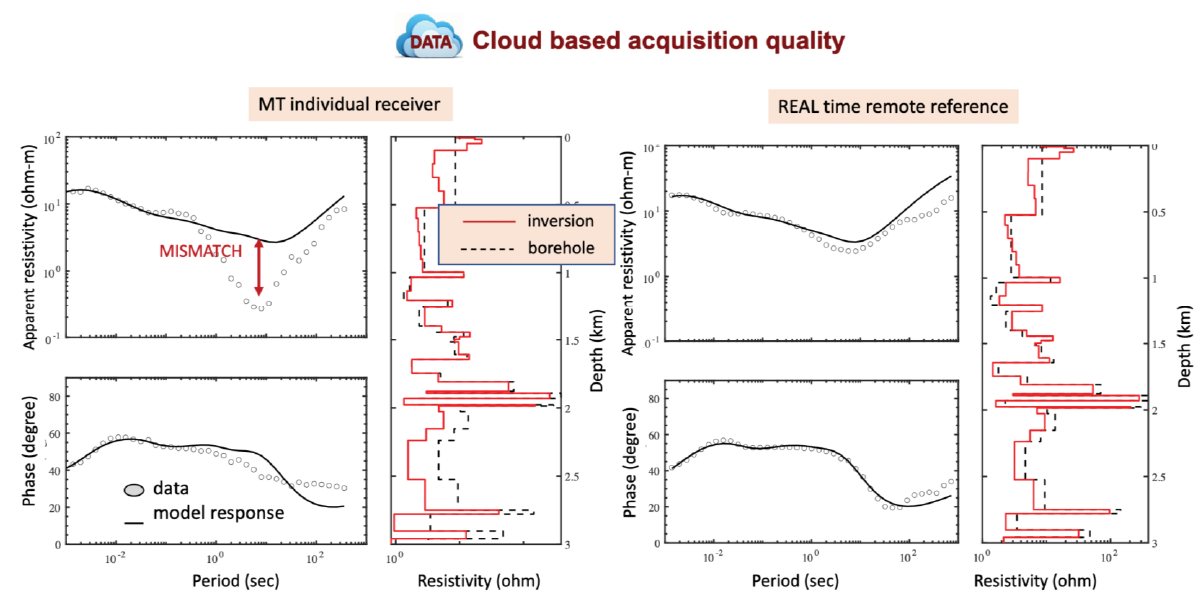
Figure 13. Comparison of magnetotelluric (MT) data using an individual site for processing and including data from a remote reference site delivered via the Cloud. The top rows show apparent resistivities and the bottom phase responses. Synthetic curves are the solid lines, and the dots are the field data. On the right of the data plots are the inversion Earth models (red line) derived from starting with the 3D anisotropic model. They are displayed in comparison with the borehole upscaled log (dashed black line).